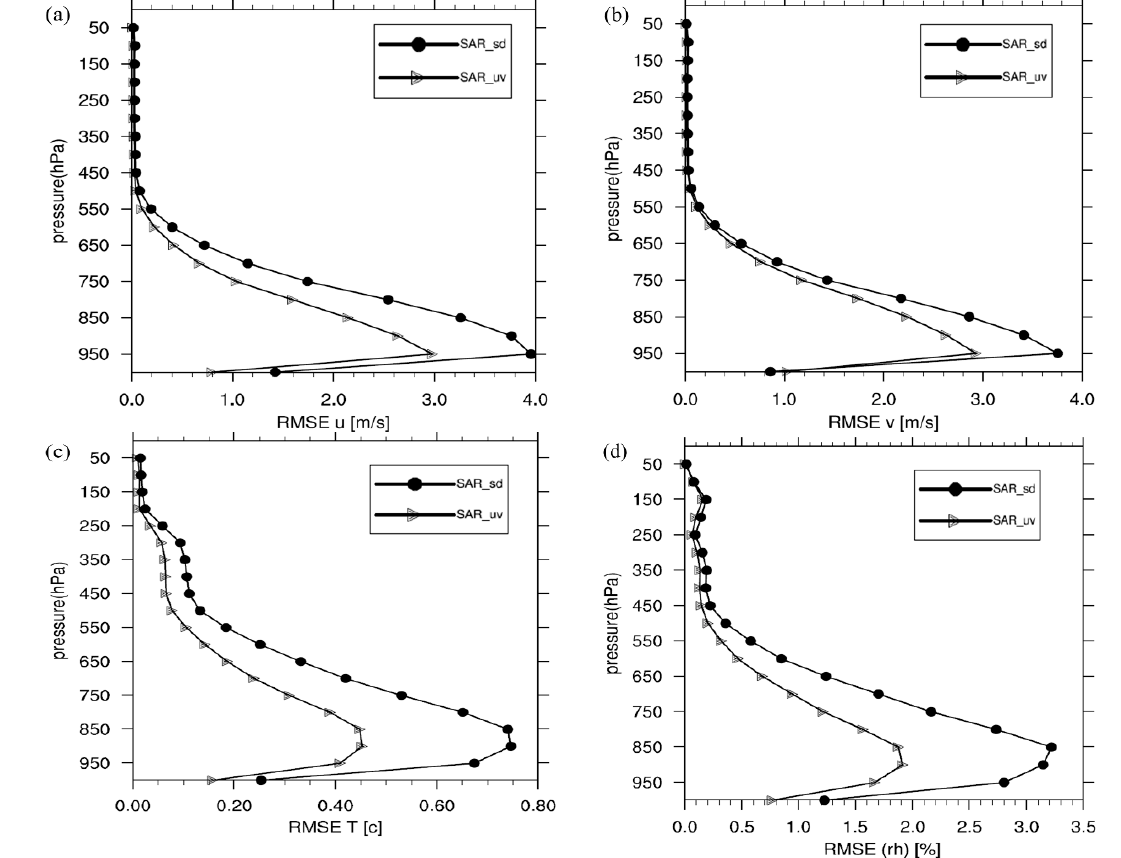
Figure 7. Root mean square error (RMSE) profiles of the analysis increments from the SAR_sd experiment (round point) and the SAR_uv experiment (triagle piont) for ( a ) u wind, ( b ) v wind, ( c ) temperature, and ( d ) relatively humidity.